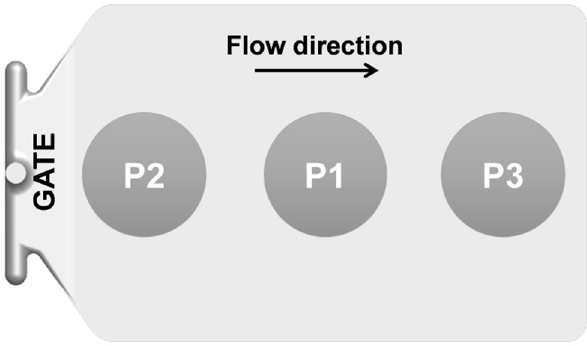
Figure 1. Schematic sketch of the sample and the related studied positions.